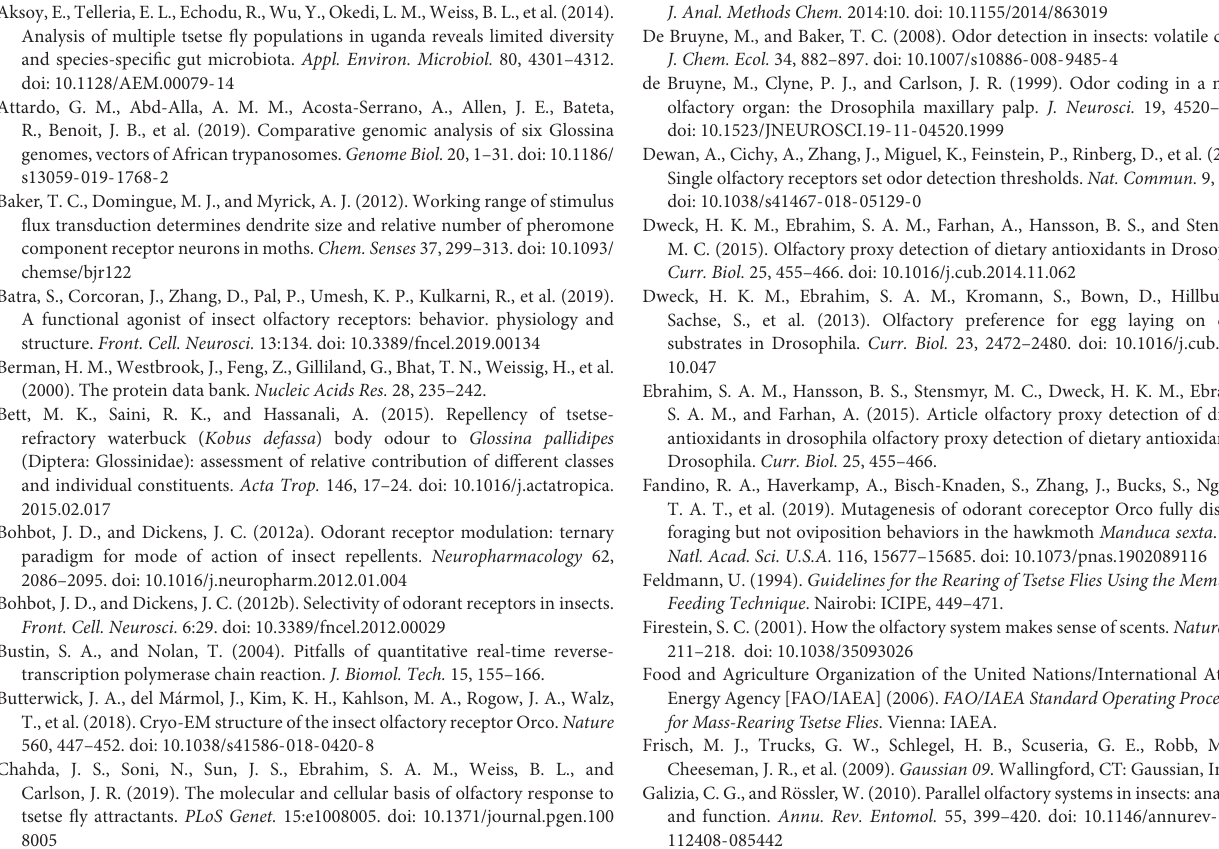
TABLE S1 | Primers used for RT-qPCR experiments.